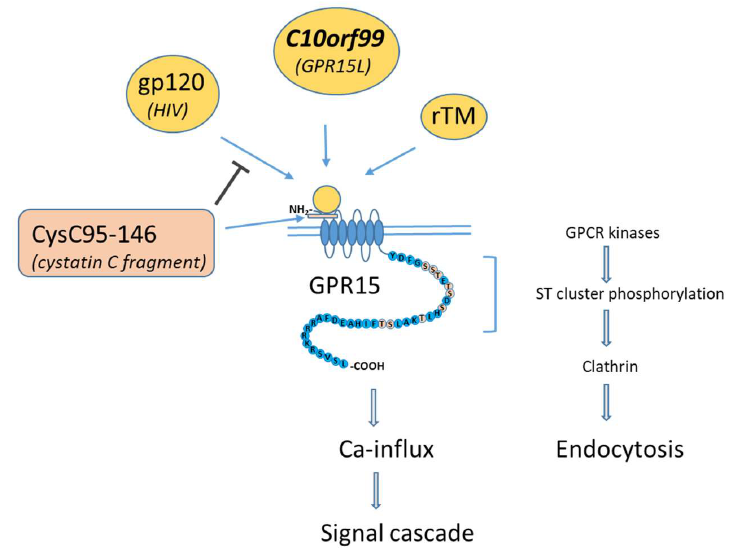
Figure 1. Protein interaction with GPR15, adapted to Okamoto et al., 2017 [17]. GPR15-activating ligands (yellow circles) bind mainly at the extracellular N terminus and to the first extracellular loop (ECL1) of GPR15. The binding protein CysC95-146 is unable to activate GPR15 but can inhibit binding to protein (gp120) of the GPR15-tropic human immunodeficiency virus (HIV). Conformational changes of ligand-bound GPR15 leads to Ca-influx and ligand-dependent endocytosis. Endocytosis is evoked by clathrin-activating phosphorylation of the ST cluster of the C-terminus of GPR15 by GPCR kinases.